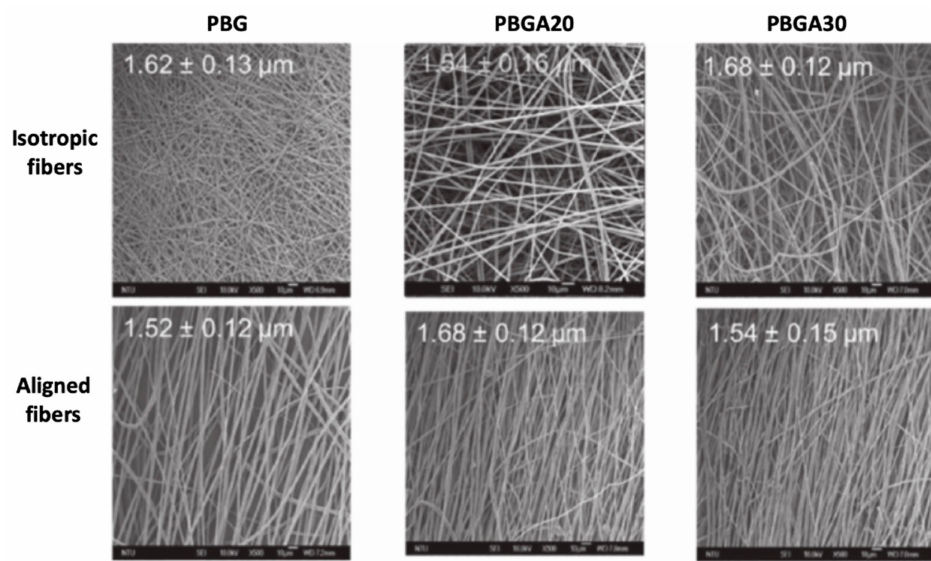
Figure 10. SEM photos of 3D scaffolds of poly(glutamates) fabricated from isotropic fibers ( top ) and aligned fibers ( bottom ). Reproduced from [82] with permission from John Wiley and